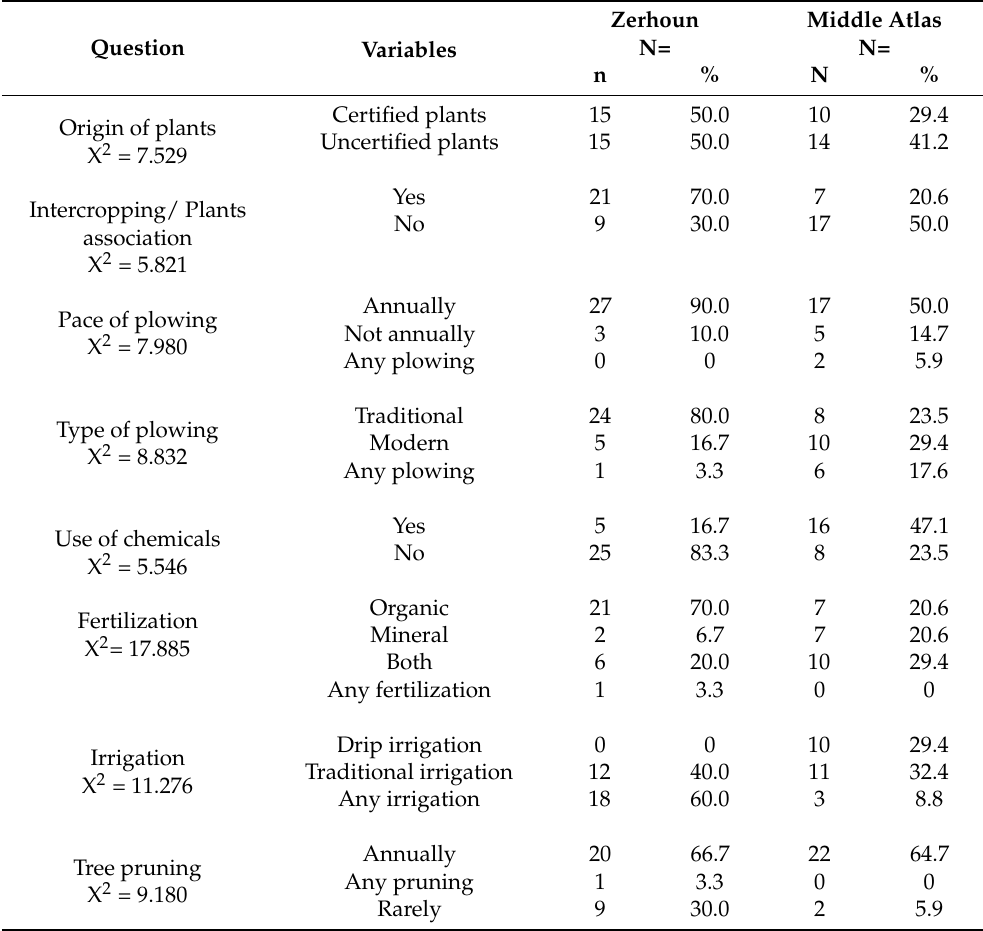
Table 2. Agricultural